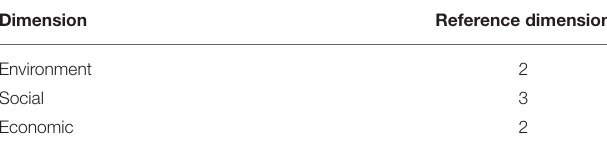
TABLE 3 | Reference value of each dimension. Dimension Reference dimension